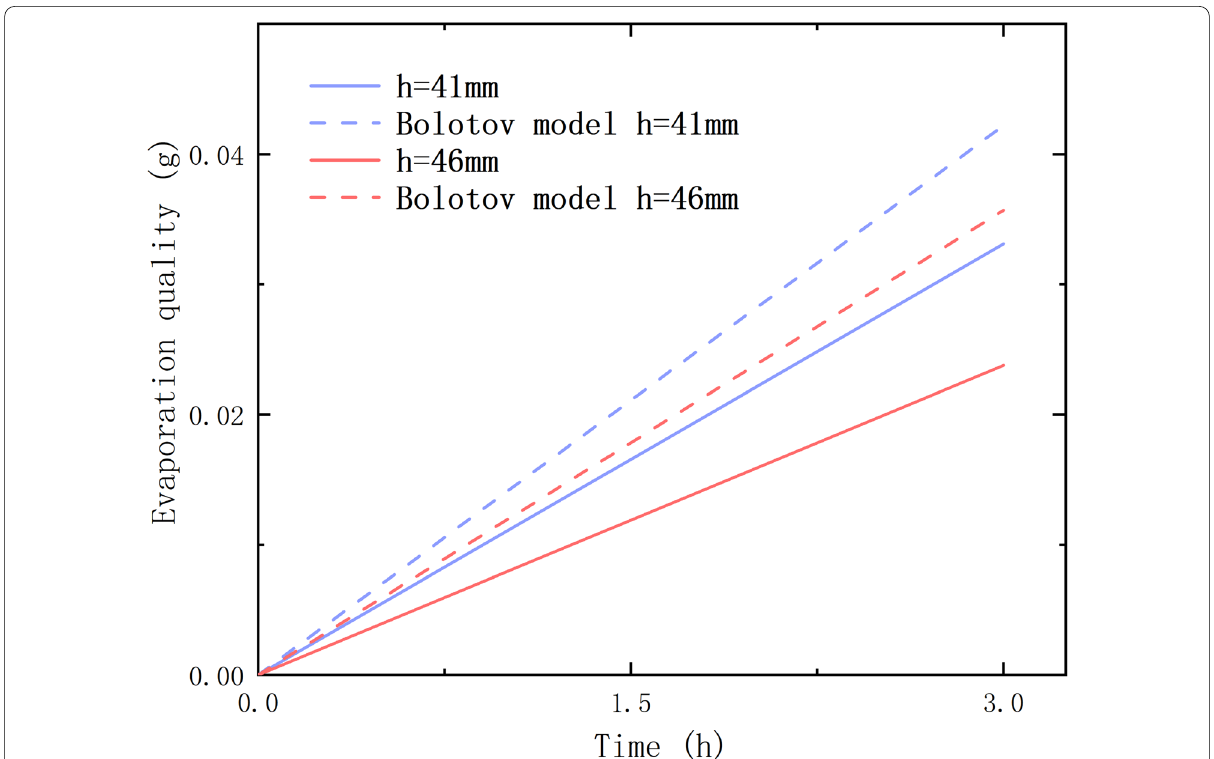
Figure 9 Prediction of the evaporation rate for ferrofluid with different